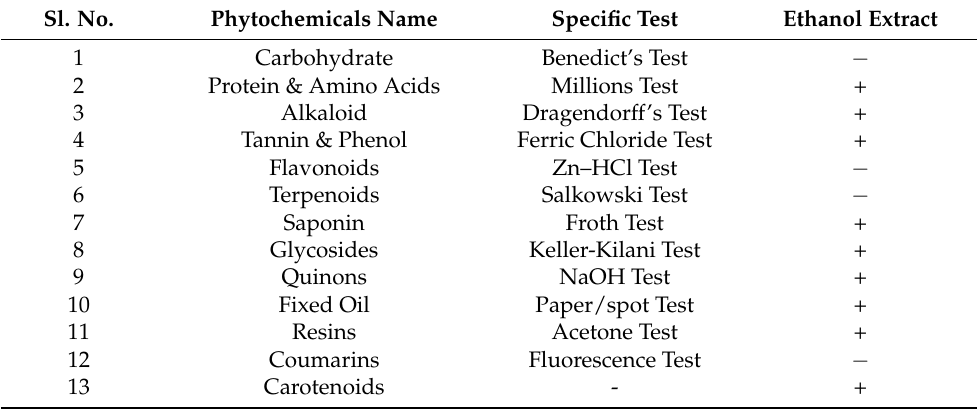
Table 1. Phytochemical (qualitative) screening of ethanol extract of M. annua .